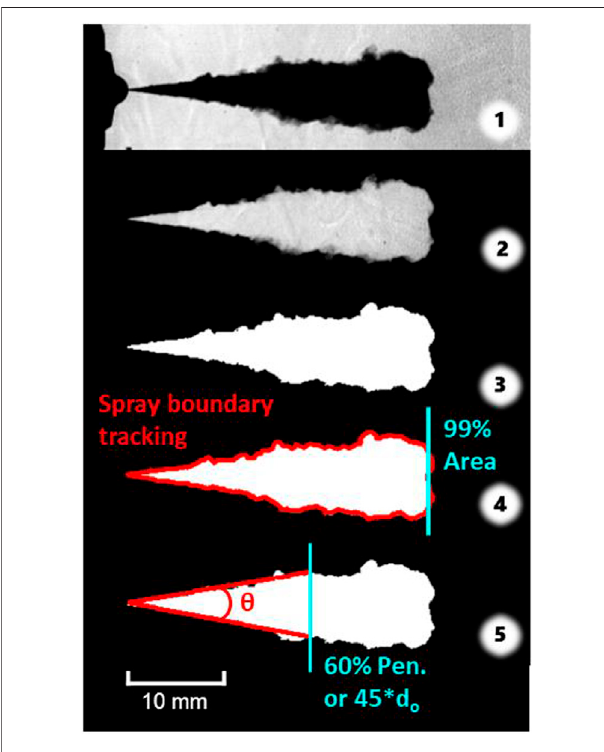
FIGURE 5 | Non-vaporizing image processing methodology, reproducedwithpermissionfromTangetal.,2017a,Tangetal.,2018,©SAE International.